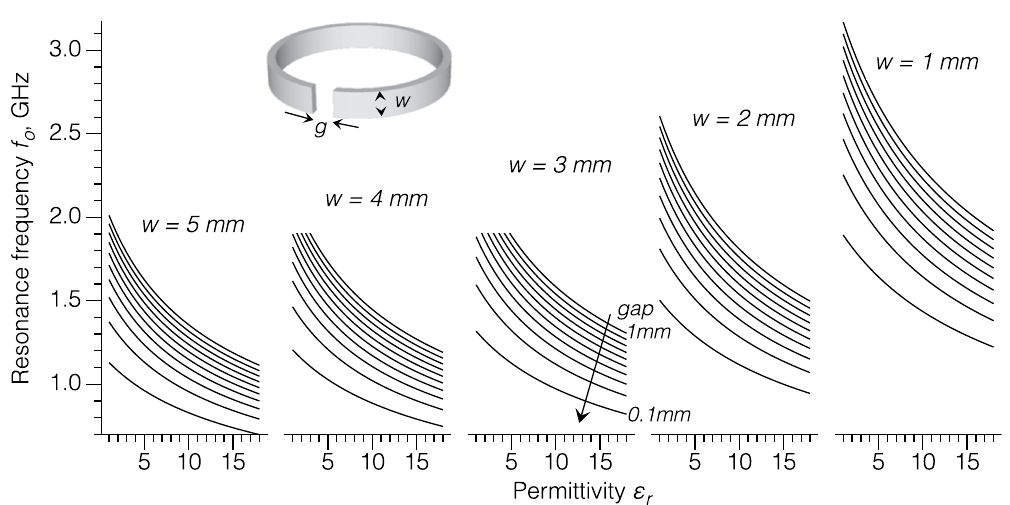
Figure 5. Calculated dependence of the resonant frequency of the SRR probe with different values of ring width w and slit gap g on dielectric permittivity of the material